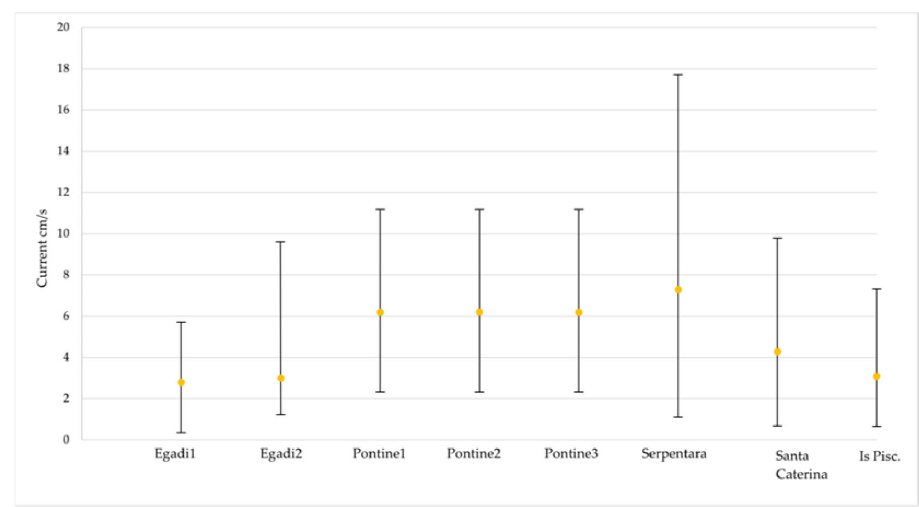
Figure 7. Scatter plot of mean current velocity per site. Bars indicate the range with the minimum and the maximum values. Measure unit: cm s − 1 .